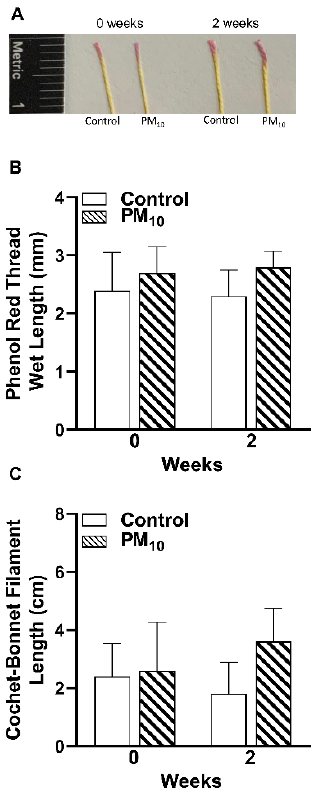
Figure 1. Effects of PM 10 exposure on tear secretion and corneal sensitivity. ( A ) Phenol red thread images. Red portion of the thread represents tear volume at 0 and 2 weeks after control or PM 10 exposure. ( B ) The wetted length (red portion) was measured and represented as a bar graph, showed no differences in tear volume. ( C ) Corneal sensitivity was measured using a Cochet-Bonnet Esthesiometer, showed no significant changes between control and PM 10 groups. Data are expressed as mean + SD. ( n = 5/group/time).